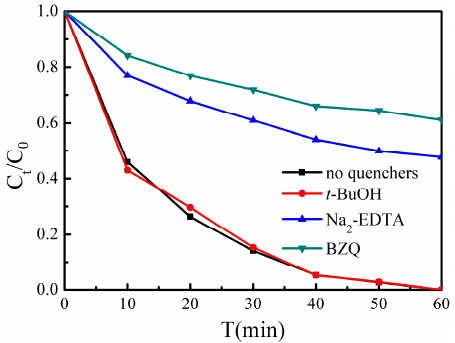
Figure 10. Reactive species trapping experiments of MB over H700 photocatalyst under visible light irradiation.